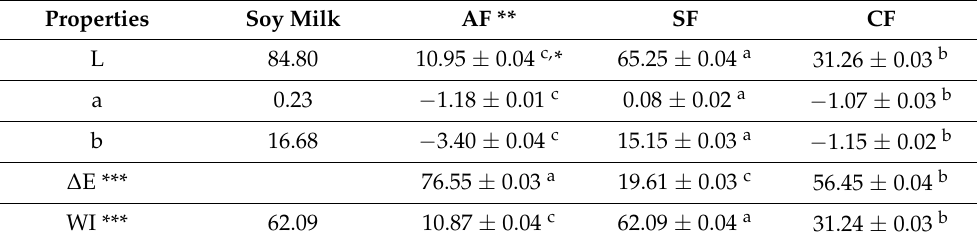
Table 5. Color of plant dietary fibers (5%, w / w ).